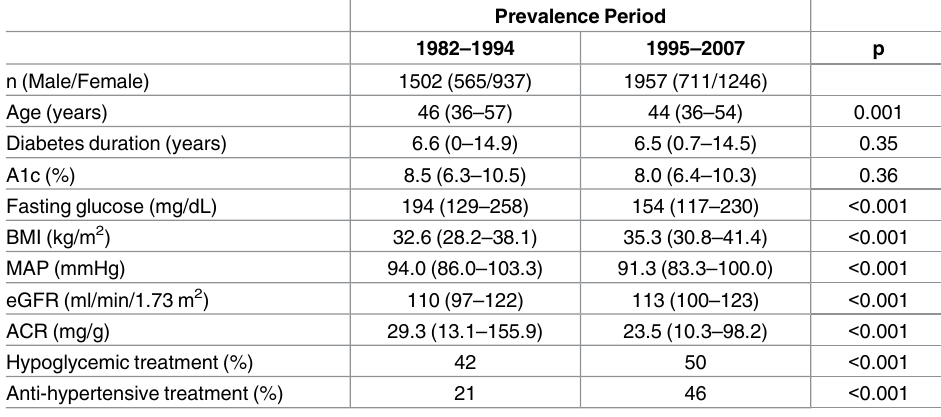
Table 1. Characteristics of the study population with type 2 diabetes for the prevalenceperiods.